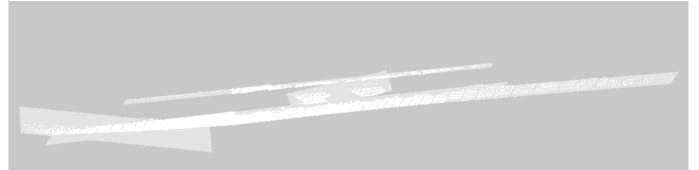
Figure 16. RANSAC fitting of the ship.